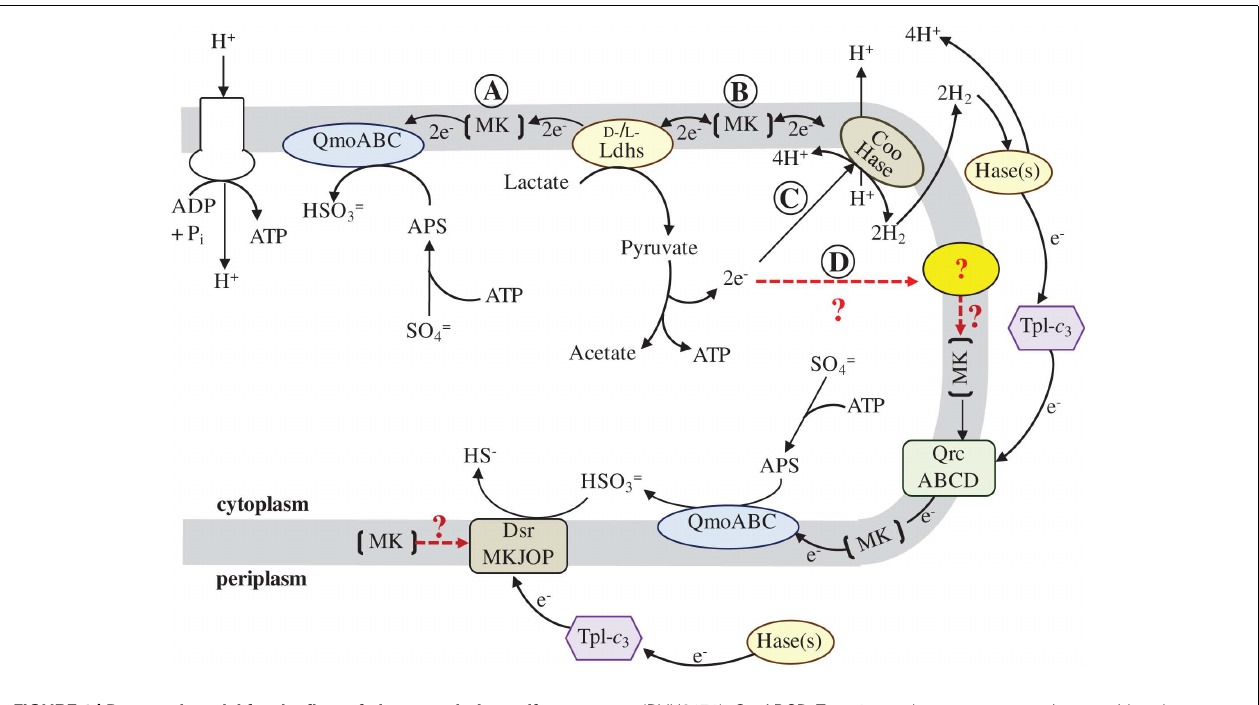
FIGURE 1 | Proposed model for the flow of electrons during sulfate respiration in D. vulgaris Hildenborough. Abbreviations: QmoABC, Quinone-interacting membrane-bound oxidoreductase (DVU0848–0850); Ldhs, lactate dehydrogenases (nine annotated); Coo Hase, CO-induced membrane-bound hydrogenase (DVU2286–2293); Hase(s), periplasmic hydrogenases (four annotated);TpI- c 3 ,Type-1 tetraheme cytochrome c 3